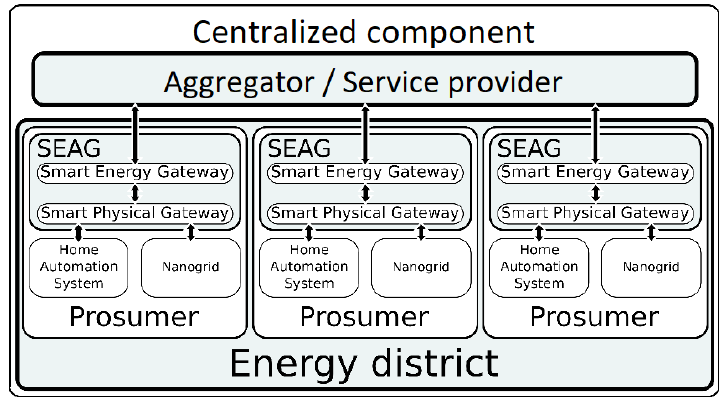
Figure 1. The energy